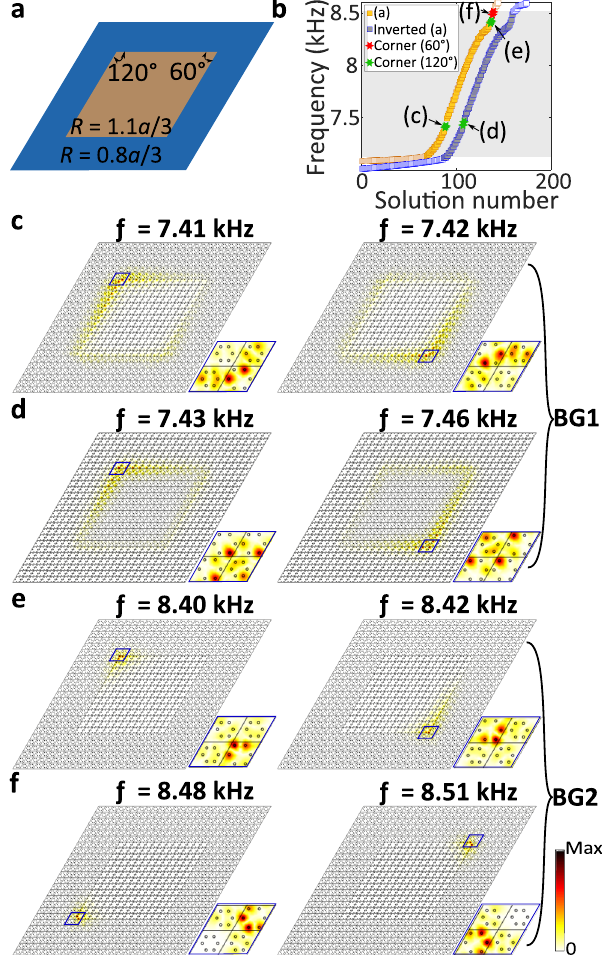
Fig. 3 The appearance of two kinds of corner state. a A rhombus-shaped structure with an interface between two domains: R = 1.1 a /3 (inner) and R = 0.8 a /3 (outer). b The eigenfrequency for the con fi guration in ( a ) and its inverted counterpart. Bulk band gap is marked in gray. Green and red stars represent the corner states. c – f Eigenmodes of the corner states corresponding to the stars in ( b ). The color map represents the amplitude of the out-of-plane displacements, ∣ w ∣